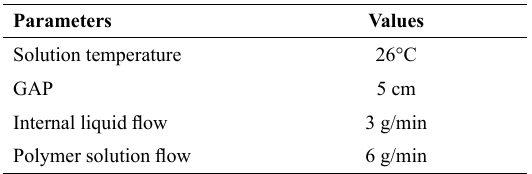
Table 1. Experimental parameters for hollow fiber membranes